Question: Does the plotted quantity increase or decrease?
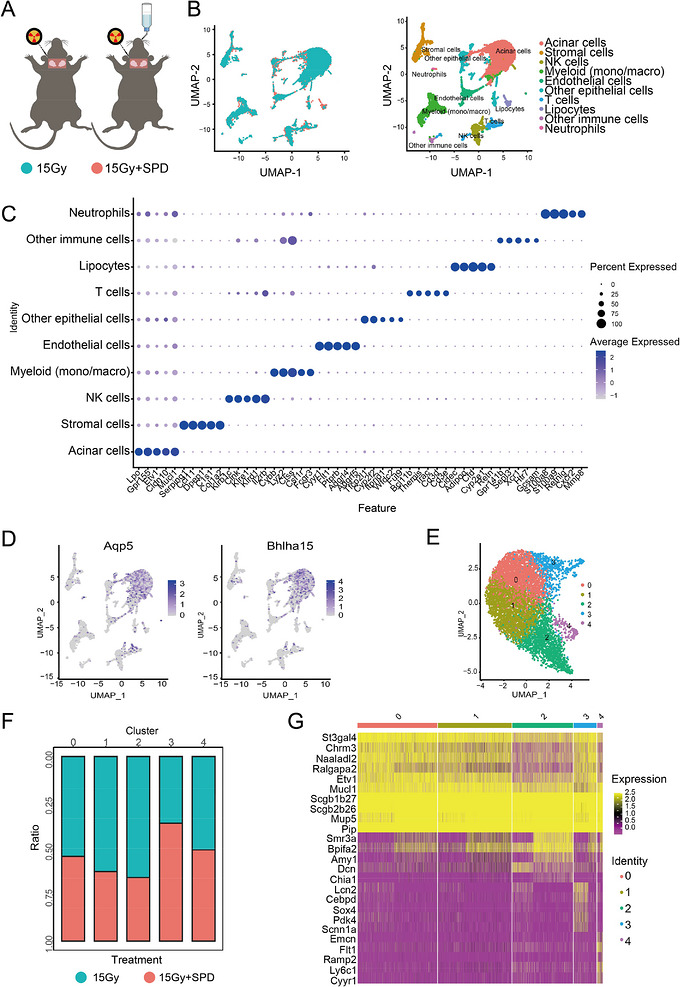
Answer: increasing